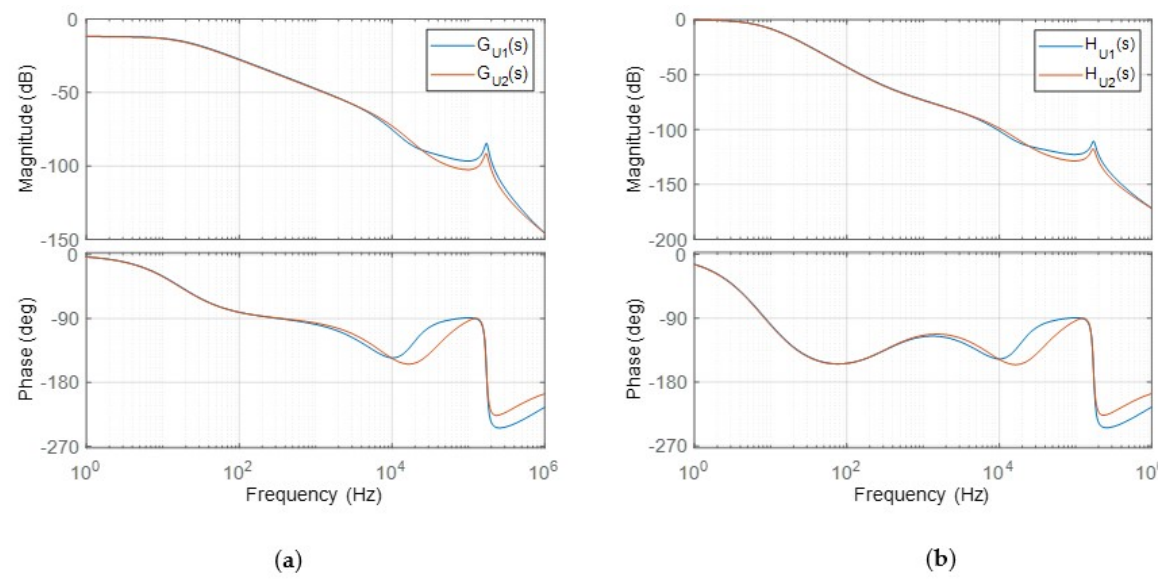
Figure 7. Bode diagrams for the system using double DD coil structure: ( a ) open-loop Bode diagram; ( b ) closed-loop Bode diagram.